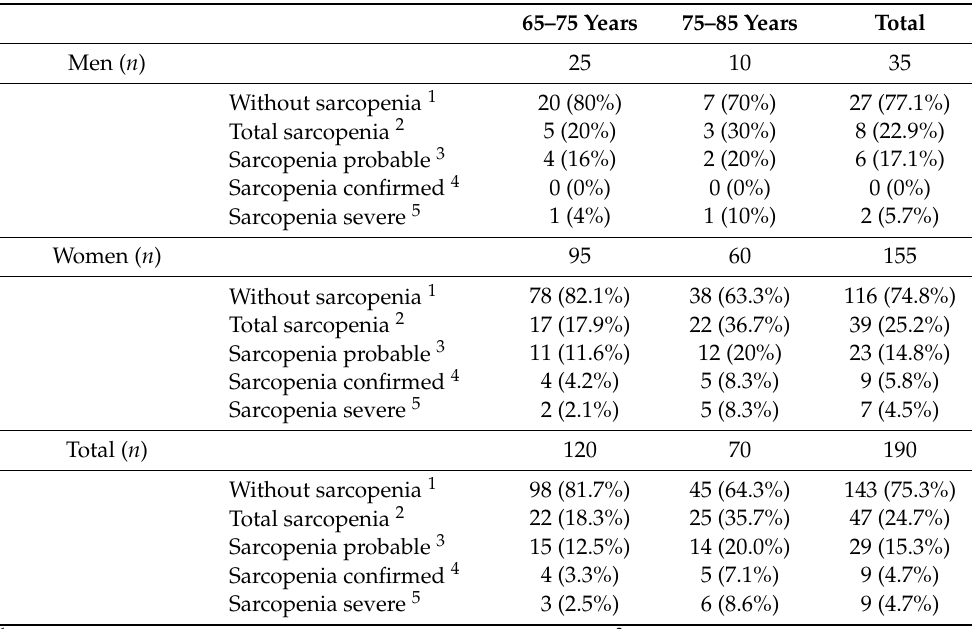
Table 1. Sarcopenic status presented by sex and age group according to European Working Group on Sarcopenia in Older People 2 (EWGSOP2) criteria.